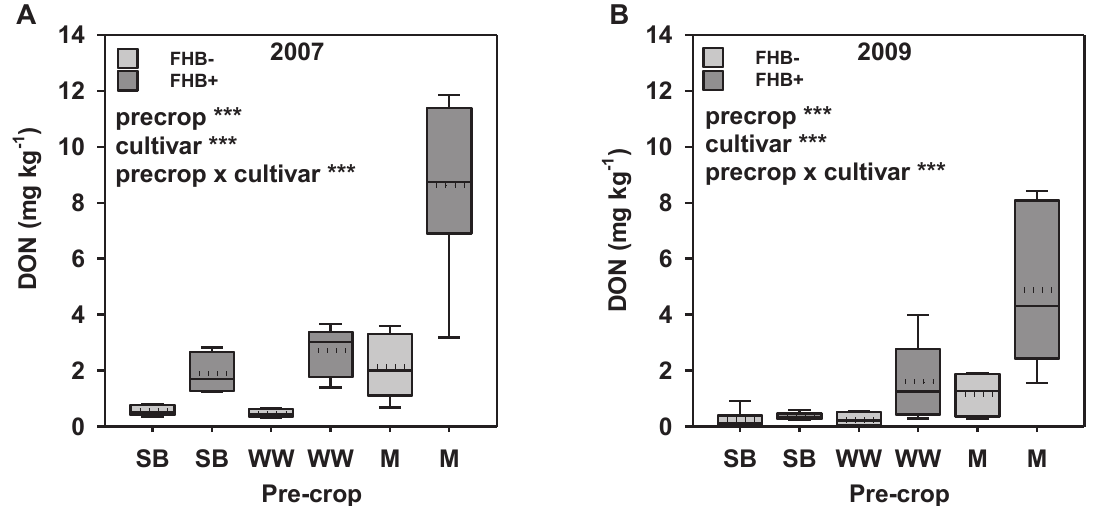
Fig. 1: Distribution of DON in flours Type 550 milled from wheat cultivated after pre-crop sugar beet (SB), winter wheat (WW), and maize (M) divided by cultivar hardly (FHB-) and highly (FHB+) susceptible against FHB in 2007 (A) and 2009 (B). Results of two-way ANOVA. Box plots show 25-75% percentile, median (solid line), and mean (dotted